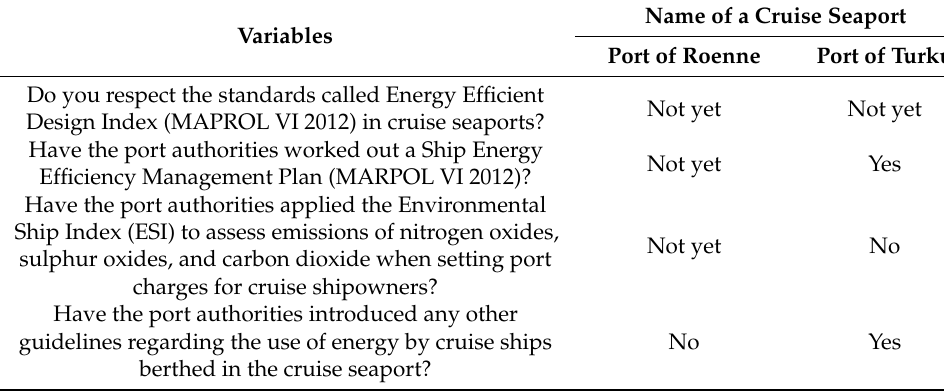
Table 4. Seaport regulations on harmful emissions from